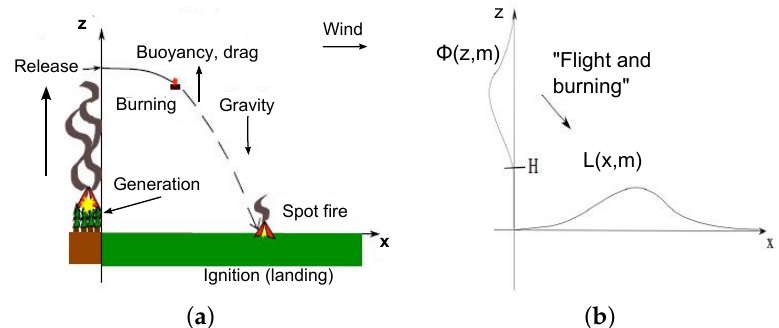
Figure 1. ( a ) Caricature of the spotting process. A cohort of firebrands are launched to various heights z above a spreading ambient forest fire. The x -direction denotes the mean ambient wind direction. The firebrands are then released and transported in the ambient windfield: combusting, falling downward due to gravity, experiencing drag and possibly buoyancy, until they finally come to rest downwind of the main fire. Depending on the local conditions for fuel and weather at the landing site, a new fire may be ignited if the firebrand is still combusting. Such a fire is called a spot fire , and the process is called spotting ; ( b ) Determining the “flight and burning” distribution L from the vertical launch distribution φ . The term “flight and burning” refers to the physical details of firebrand flight and combustion, which we will discuss in detail in the Appendix. Shown in the vertical is a cross-section of the launching distribution φ ( z , m ) for some fixed m > 0. A possible asymptotic landing distribution L ( x , m ) is plotted here in the